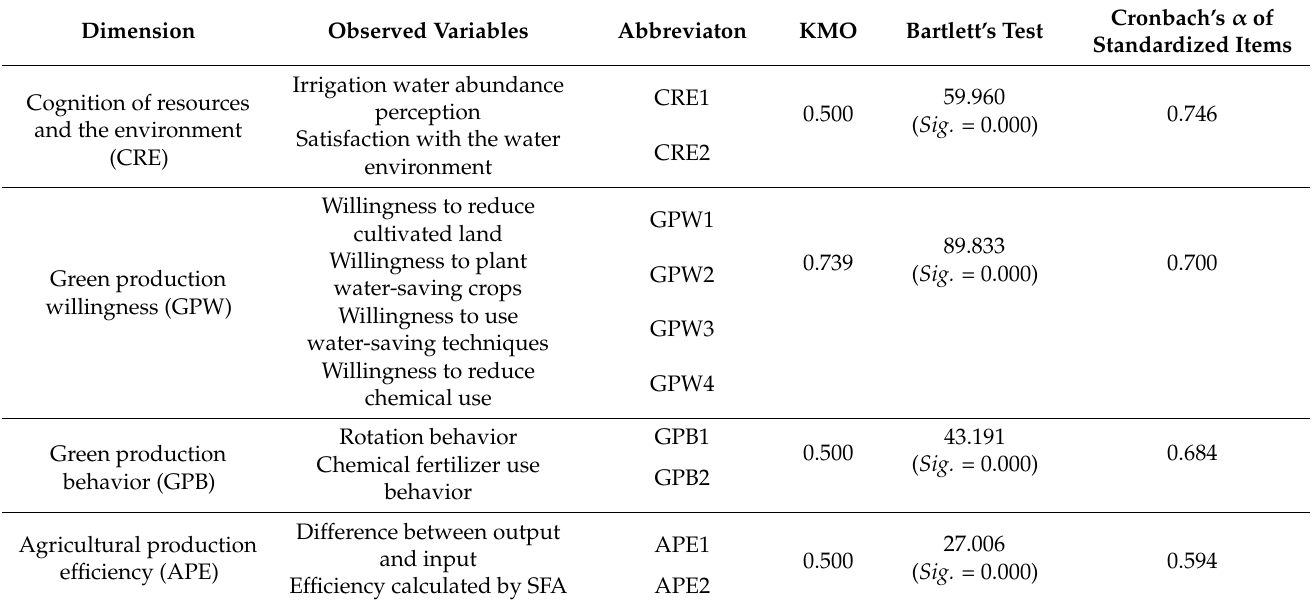
Table 5. Questionnaire reliability analysis results.